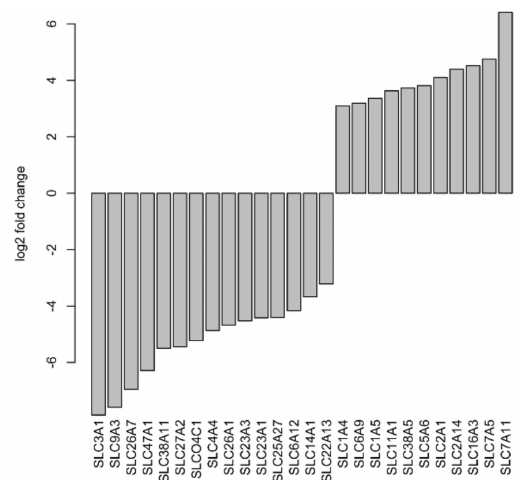
Figure 5. Deregulated solute carrier genes at | log2fold change | ≥ 3 in CDC samples compared to normal